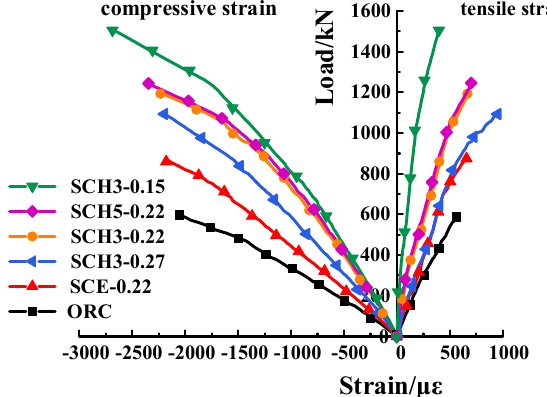
Figure 11. Load-strain curve of concrete and ECC.